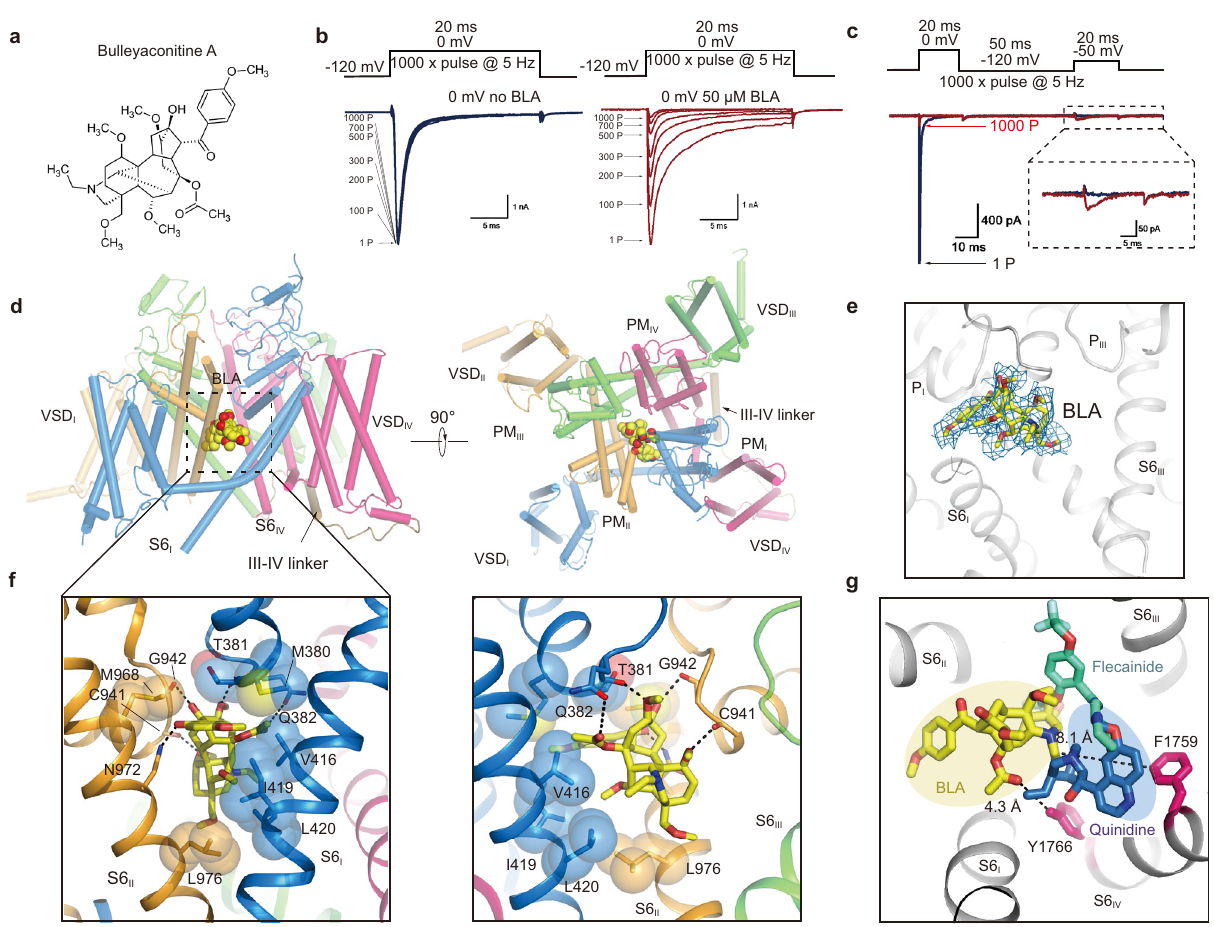
Fig. 2 The binding site of BLA in Na V 1.3. a The chemical structure of BLA. b BLA reduces peak current of Na V 1.3 in a use-dependent manner. Na V 1.3 transfected HEK293T cells were measured using a recording protocol of 1000 repetitive test pulses at 0 mV from holding potential (HP) at − 120 mV at 5-Hz frequency without BLA (left panel), the traces showed robust and stable sodium in fl ux after 1000 pulses. Transfected cells in bath solution containing 50 μ M BLA were measured using the same recording protocol and the current traces showed progressive inhibition of Na V 1.3 (right panel). Similar data were acquired from 6 cells in the absence or presence of BLA. c BLA elicits weak activation of Na V 1.3 after binding. Two-pulse protocol, which is composed of a fi rst 20-ms test pulse at 0 mV, backing to − 120 mV for 50-ms followed by a second 20-ms test pulse at − 50 mV, was used to elicit the activation of Na V 1.3 by 50 μ M BLA for 1000 repetitive pulses at 5-Hz frequency. The current trace of the fi rst pulse (1 P) and the 1000 pulse (1000 P) are colored in black and purple, respectively. Similar data were acquired from 6 cells. d BLA binding site in Na V 1.3. The complex structure is shown in side view (left panel) and top-down (right panel) view with BLA depicted in sphere models. The black dashed square indicates the area to be shown in panel ( f ). e The density at 3 σ is shown in blue mesh for BLA, which is depicted in sticks. f Detailed binding site for BLA showing interactions between BLA and Na V 1.3. The side chains of key residues are shown in sticks. Black dashed lines represent hydrogen bonds. g Comparison of the BLA binding site in Na V 1.3 with the fl ecainide and quinidine binding sites in Na V 1.5. Black dashed lines indicate the closest distances from BLA to F1759 and